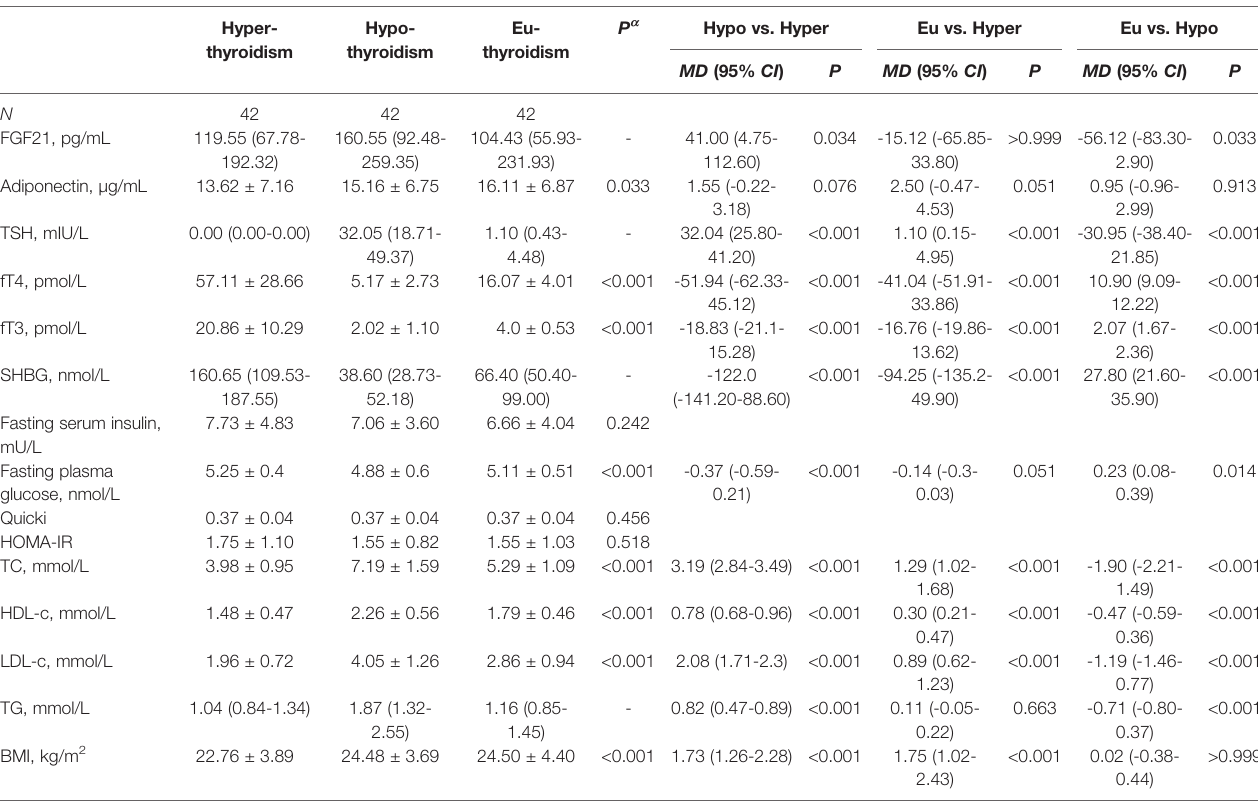
TABLE 2 | Serum FGF21 and biochemical parameters after RAI treatment in hyper-, hypo-, and euthyroid phase. Hyper-